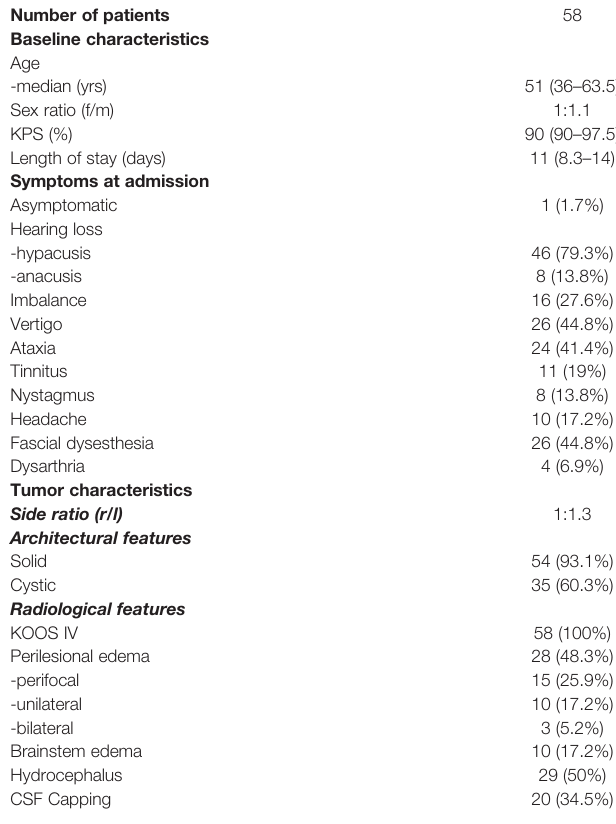
TABLE 1 | Baseline characteristics, symptoms at admission and tumor